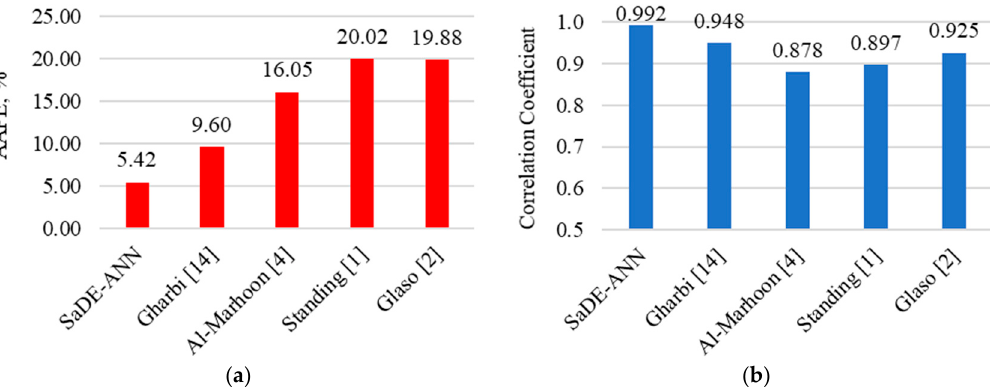
Figure 4. Comparison between different models and correlations based on ( a ) the average absolute percentage error (AAPE) and ( b ) the correlation coefficient (CC).